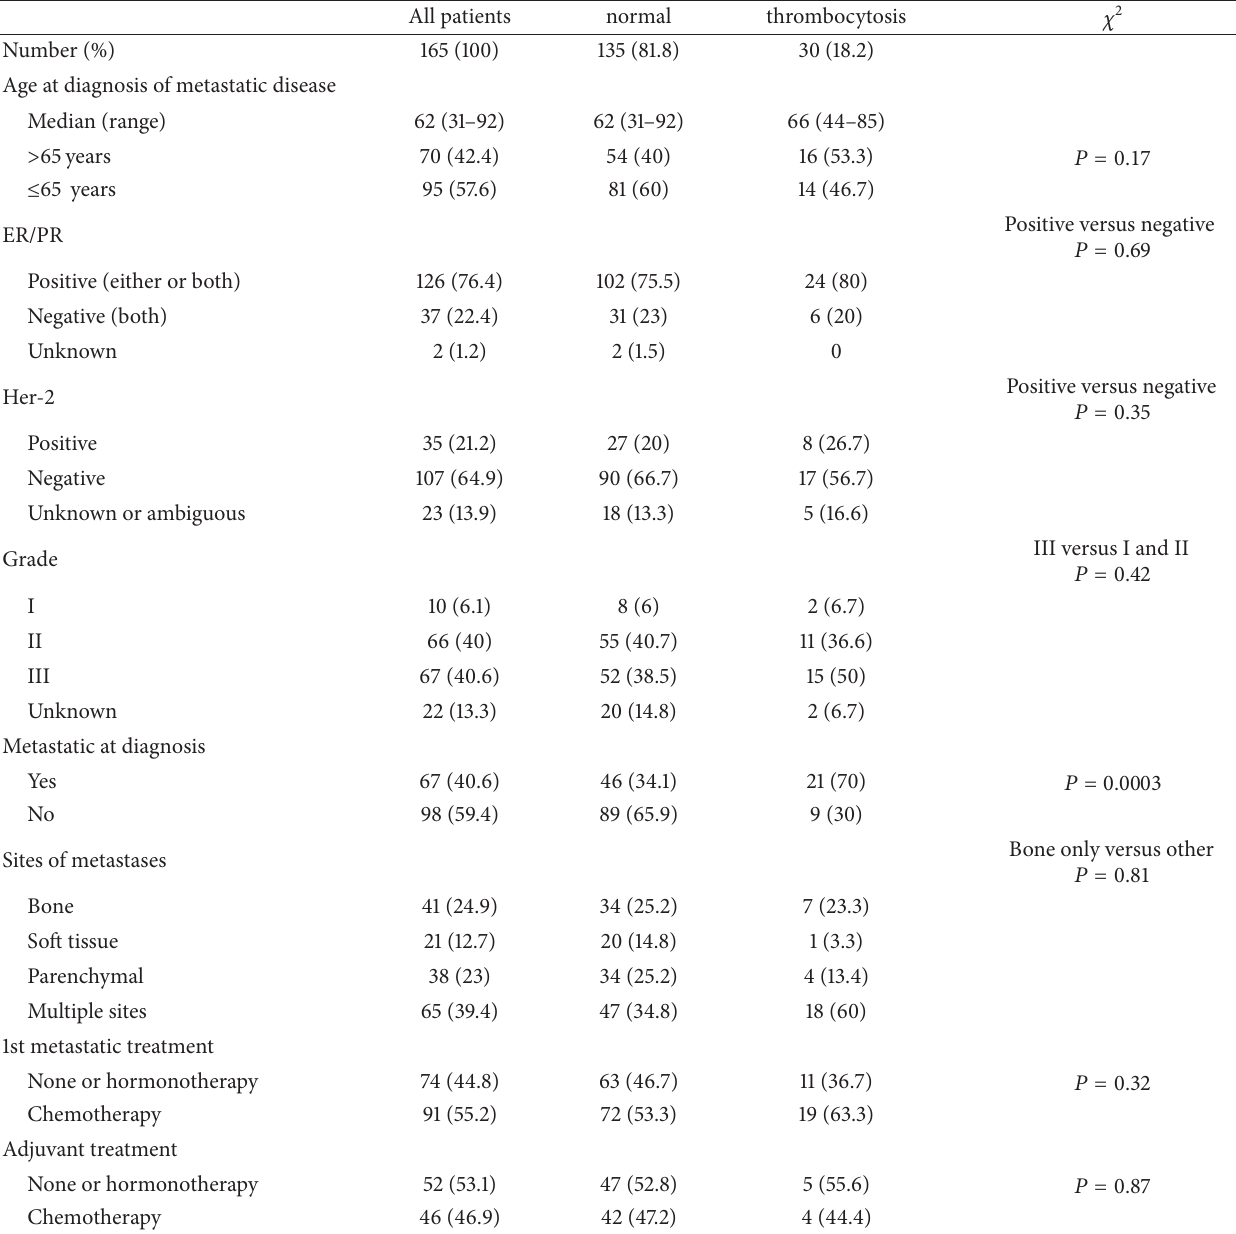
Table 1: Characteristics and outcome of patients in the series. Column “All patients” includes the whole series of patients with normal platelets or thrombocytosis. 𝜒 2 test between the group with normal platelet count and the group with thrombocytosis is shown. Wherever there are more than two categories, the grouping of the comparison is mentioned in the same column. Her-2 was defined as positive if 3+ by IHC or amplified by FISH and negative if 1+ by IHC or 2+ by IHC and FISH not amplified or not